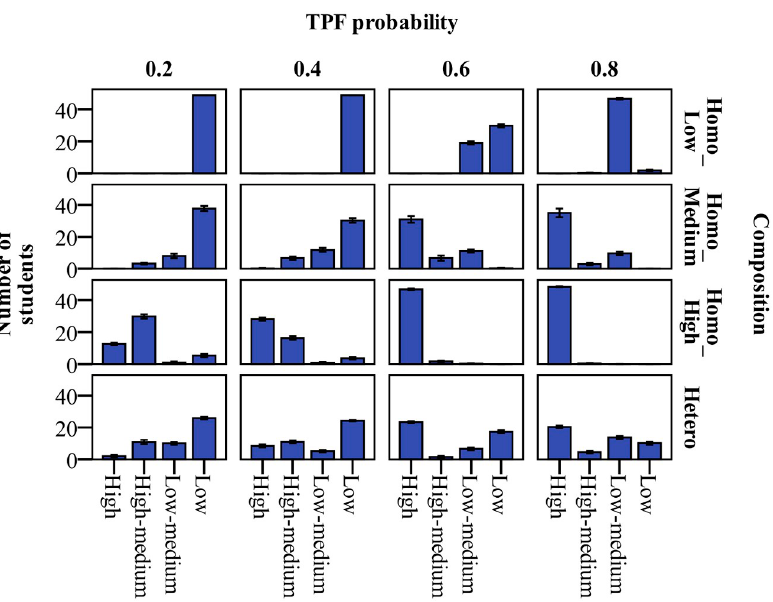
Fig 3. Simulated distribution of classroom engagement under teacher feedback effects and near-seated peer group influence. “TPF” = teacher’s positive feedback. “Composition” refers to class engagement composition, including four scenarios: low-engagement homogeneous (Homo_Low), medium-engagement homogeneous (Homo_Medium), and high-engagement homogeneous (Homo_High) and heterogeneous groups (Hetero: half low- and half high- engagement students). Under the effects of teacher’s positive feedback probability and class engagement composition, the numbers of students with high, high-medium, low-medium and low classroom engagement rate are